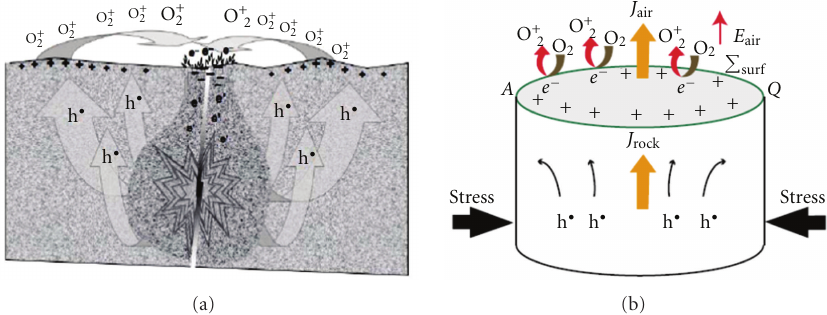
Figure 7: (a) conception of the positive EF field generation on the ground surface from Freund [19]; (b) modified conception of the positive EF generation on the ground surface from Koons et al.